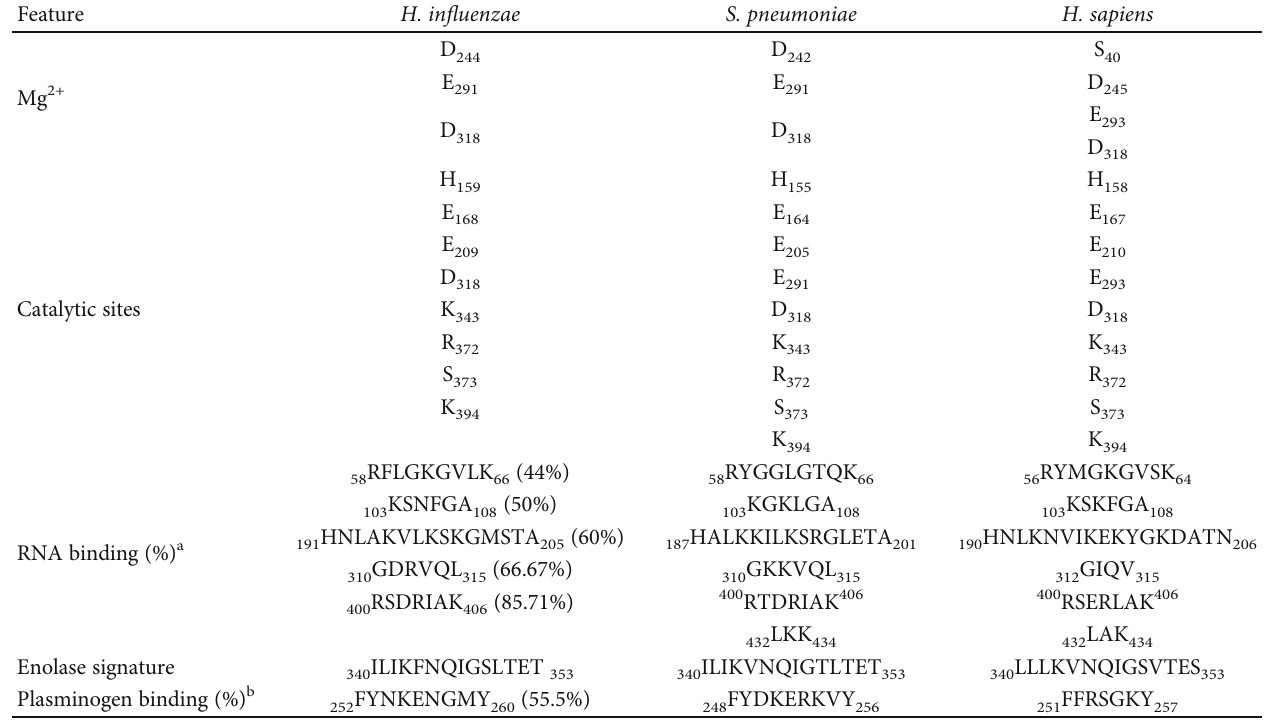
Table 1: Biochemical characteristics of NT H. in fl uenzae enolase.